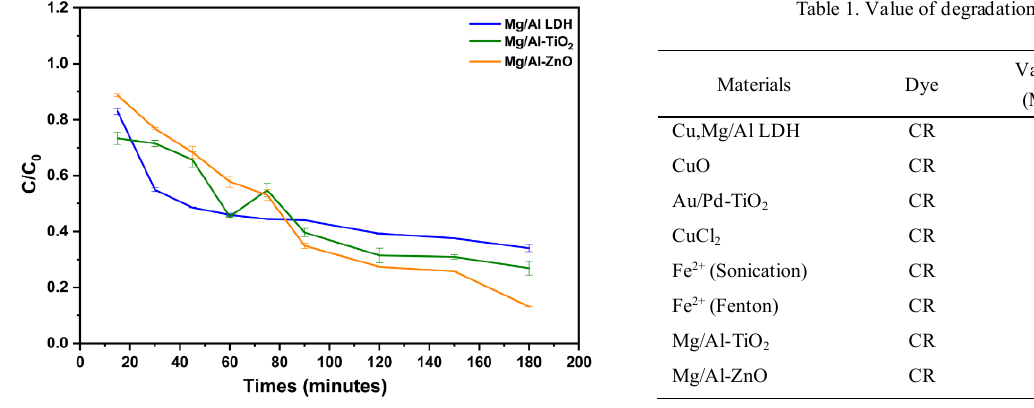
Fig. 5. Effect of time radiation on CR photodegradation